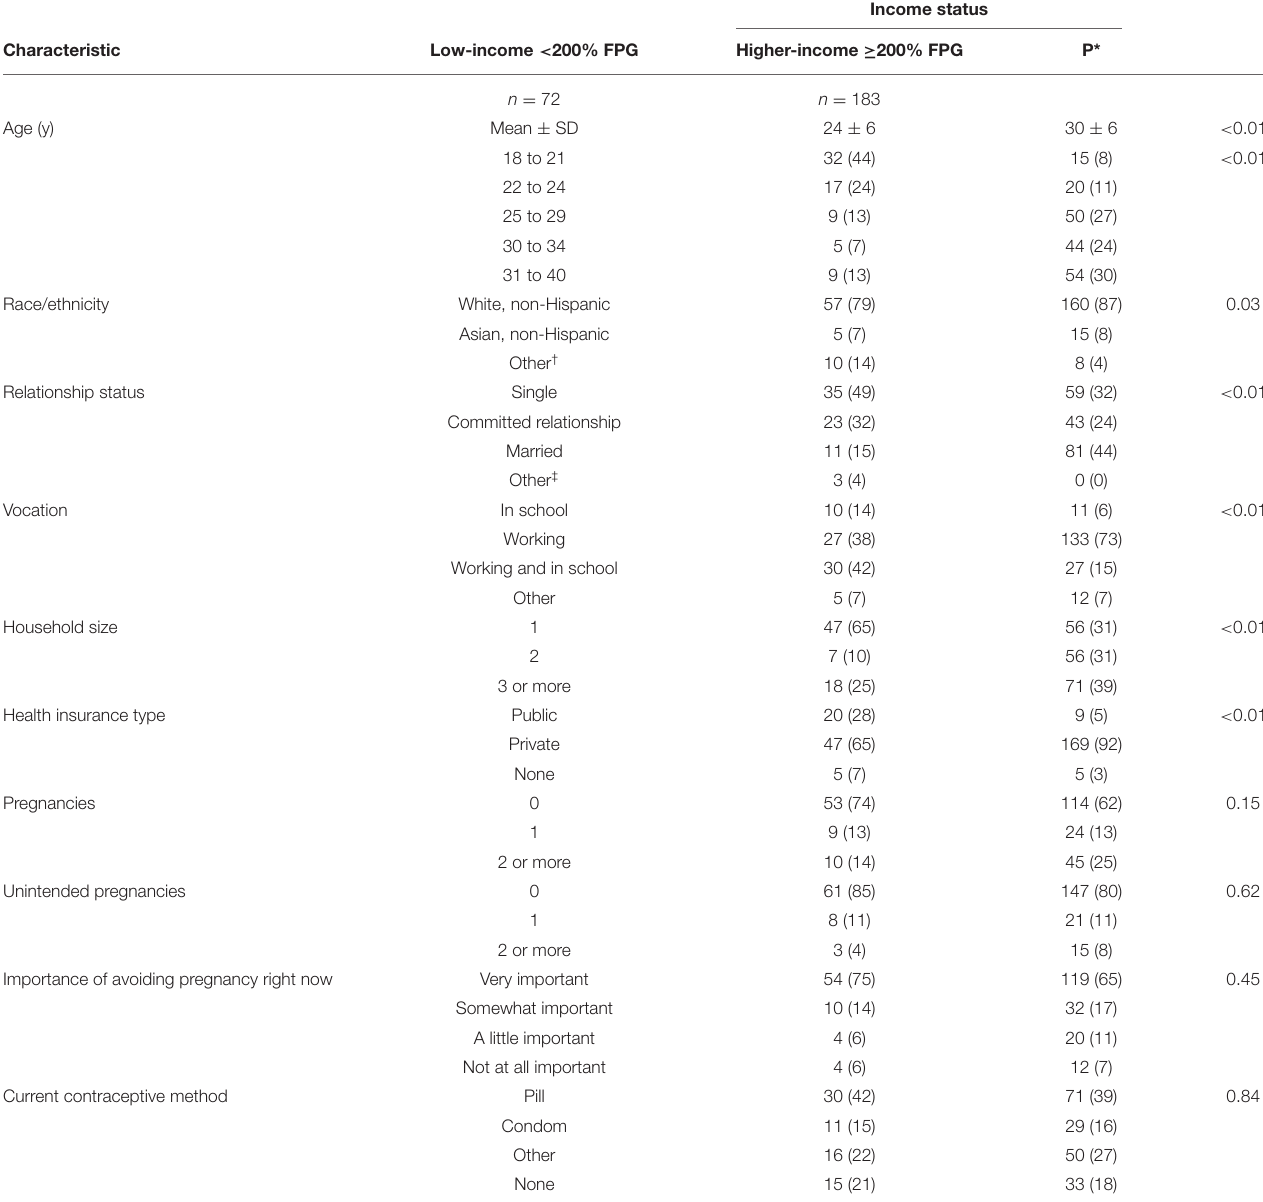
TABLE 1 | Demographic and reproductive health characteristics of participants by income